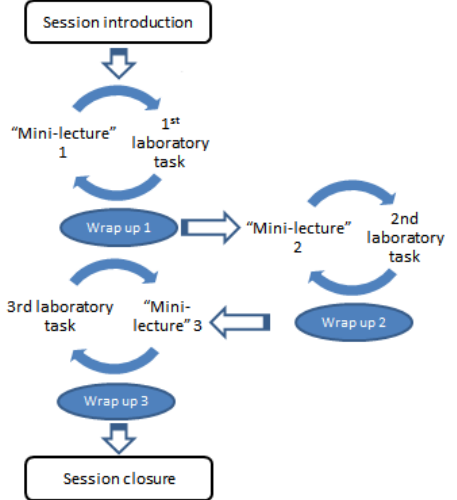
Figure 2. Second design model for face-to-face teaching sessions for computing courses extensively using enterprise level systems in their curriculum